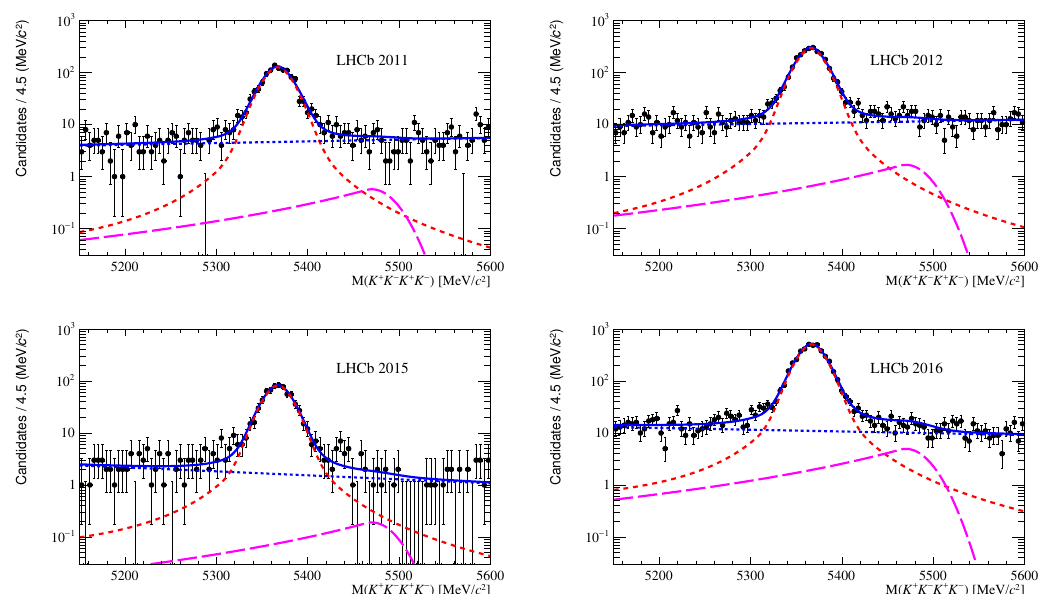
Figure 1 . A (cid:12)t to the four-kaon mass for the (top left) 2011, (top right) 2012, (bottom left) 2015 and (bottom right) 2016 data sets, which are represented by the black points. Also shown are the results of the total (cid:12)t (blue solid line), with the B 0 long dashed), and the combinatorial (blue short dashed) (cid:12)t